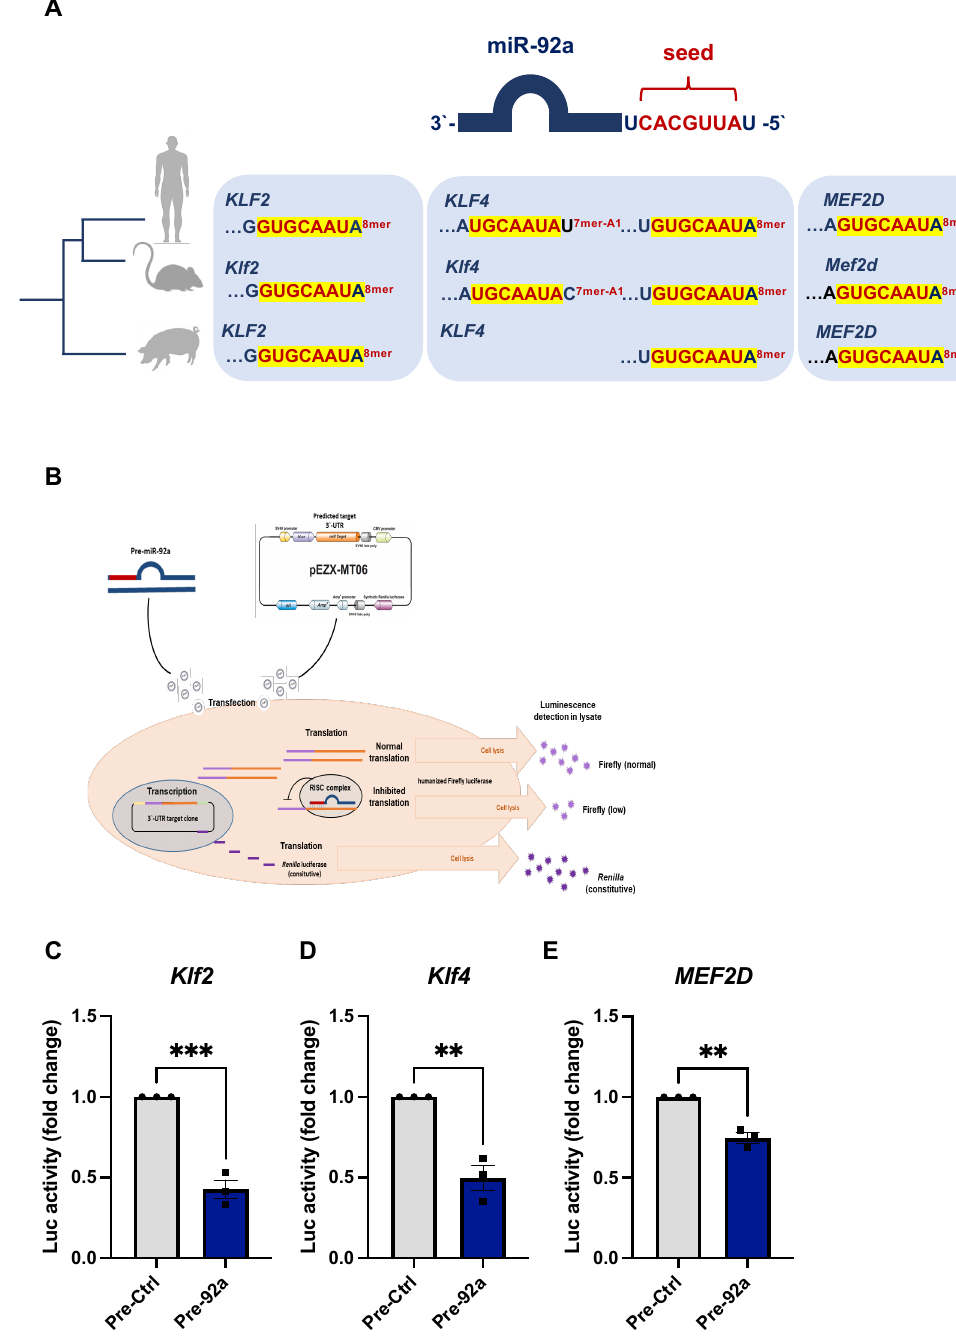
Figure 4. Evolutionary conservation and direct targeting of KLF2 , KLF4 , and MEF2D 3‘-UTRs by miR-92a. ( A ) In silico analysis results of evolutionarily conserved target sequence of miR-92a seed sequence in KLF2 , KLF4 , and MEF2 D in humans, mice, and pigs highlighting binding sites and complementarity. ( B ) Depiction of dual luciferase reporter assay of direct interaction between miR-92a and its targets. ( C – E ) Dual luciferase reporter assay of ( C ) Klf2 , ( D ) Klf4 , and ( E ) MEF2D 3‘-UTR reporters, respectively analyzed for fold-change in luciferase activity upon miR-92a overexpression (pre-92a) relative to controls (pre-Ctrl). Statistical analyses by unpaired Student’s t -test ( n = 3); ** p < 0.01; *** p <